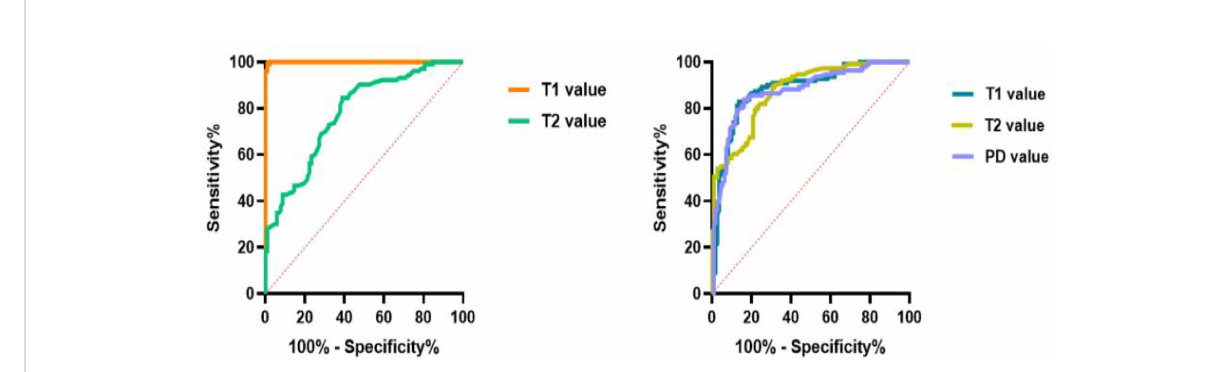
FIGURE 3 Graphs show the receiver operating characteristic curves calculated from T1, T2, and proton density (PD) values in detecting bone marrow edema (BME) and fat